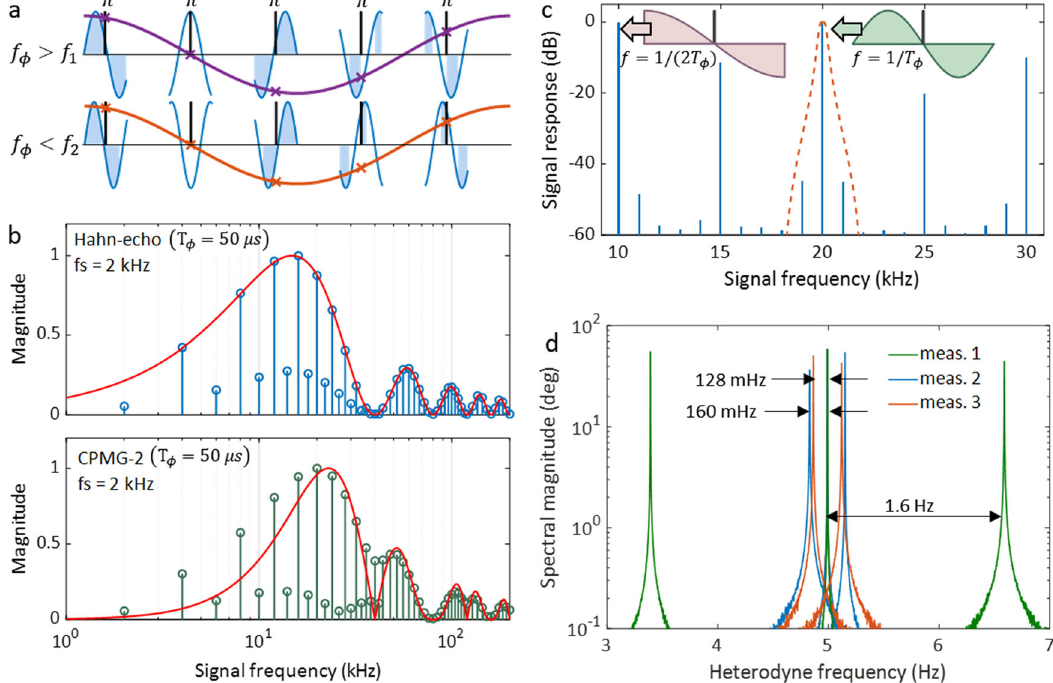
Fig. 3 | Frequency offset heterodyne readout. a Principle of the readout scheme. f ϕ is the reference frequency de fi ned by the sequence, and f 1 , f 2 are the frequencies of the signals. The colored regions mark where the quantum phase is accumulated in the Hahn-echo sequence, while phase accumulations at the other areas are canceled in the spin evolution. The fi gure shows iden- tical heterodyne signals due to f ϕ − f 1 = f 2 − f ϕ . b Frequency responses of the Hahn-echo sequence and CPMG-2 sequence. The applied ac fi elds have an 5Hz offset to the denoted signal frequencies so that they are detected as a 5 Hz heterodyne readout. Both theoretical and experimental results are plotted